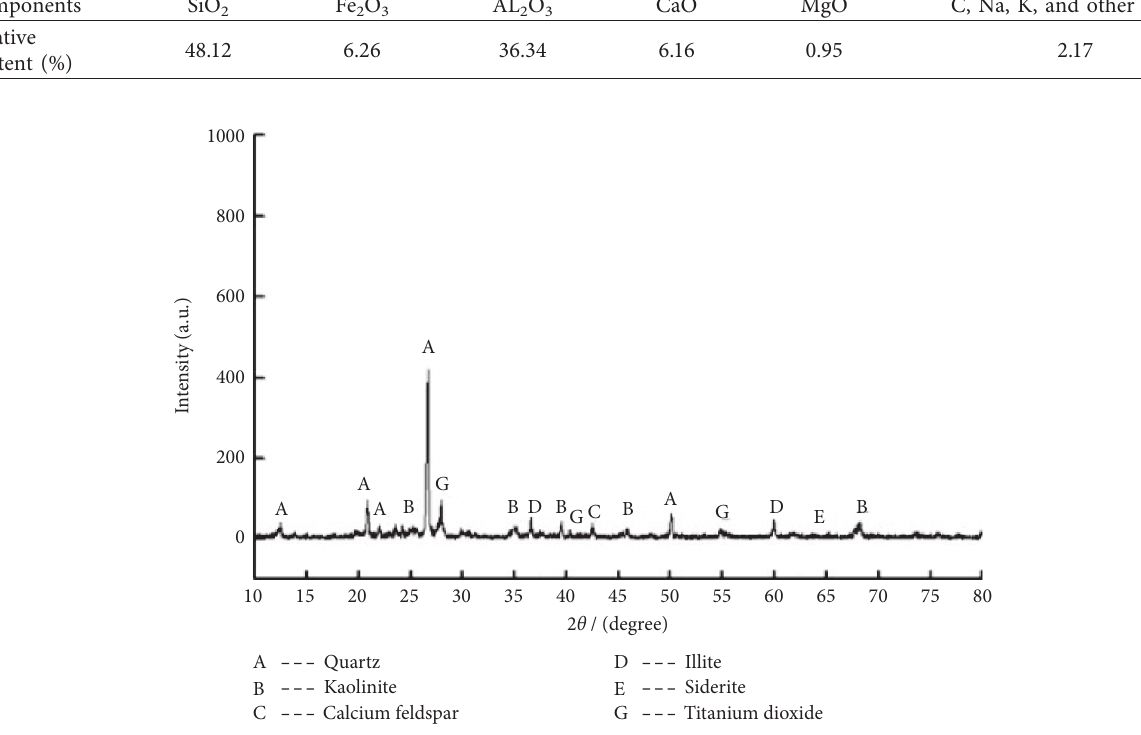
Figure 1: XRD diffraction pattern of coal gangue. Table 3: Mixture ratio of coal gangue ceramsite concrete.